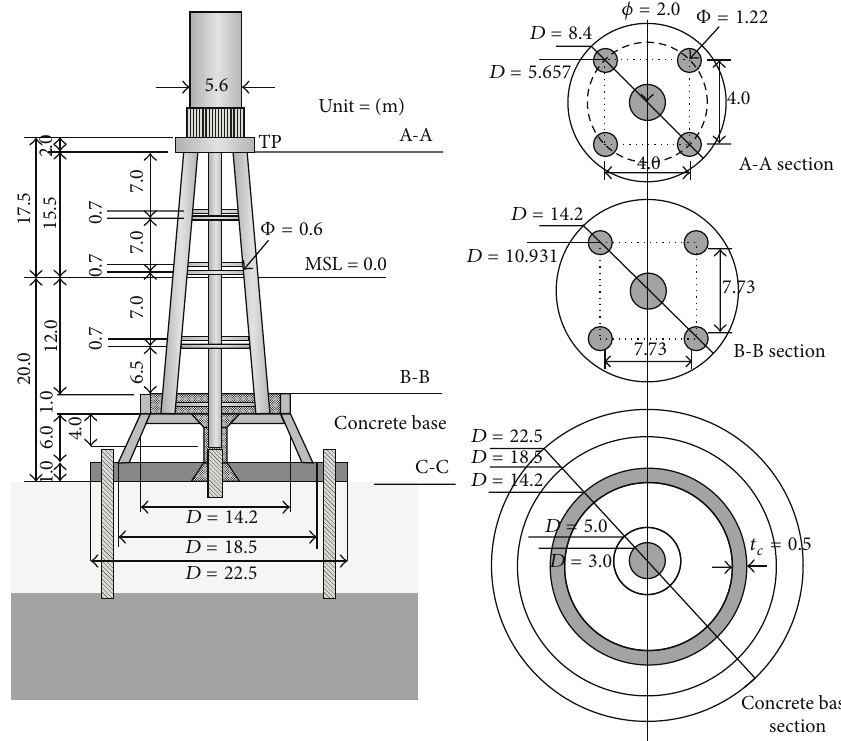
Figure 1: Geometrical configuration of the hybrid substructure.